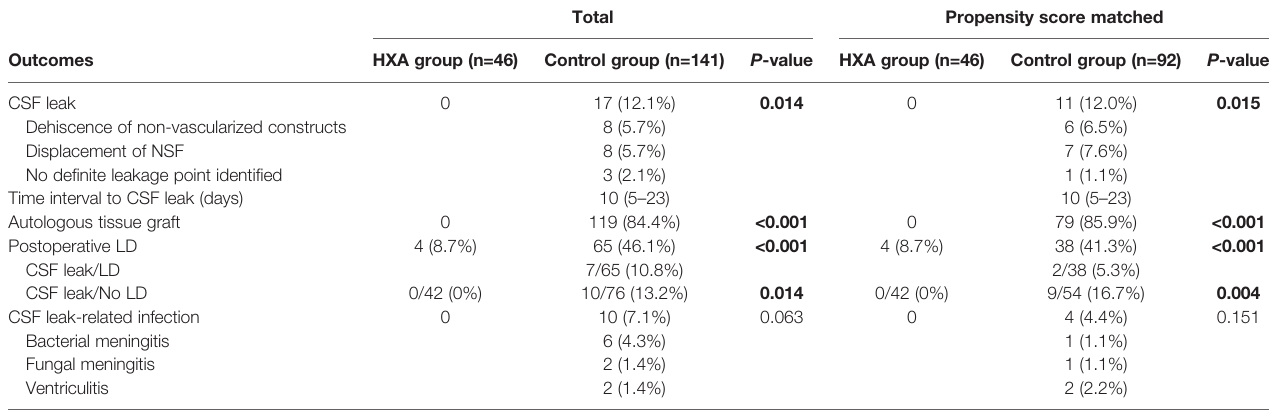
TABLE 2 | Clinical outcome comparison between the HXA group and the control